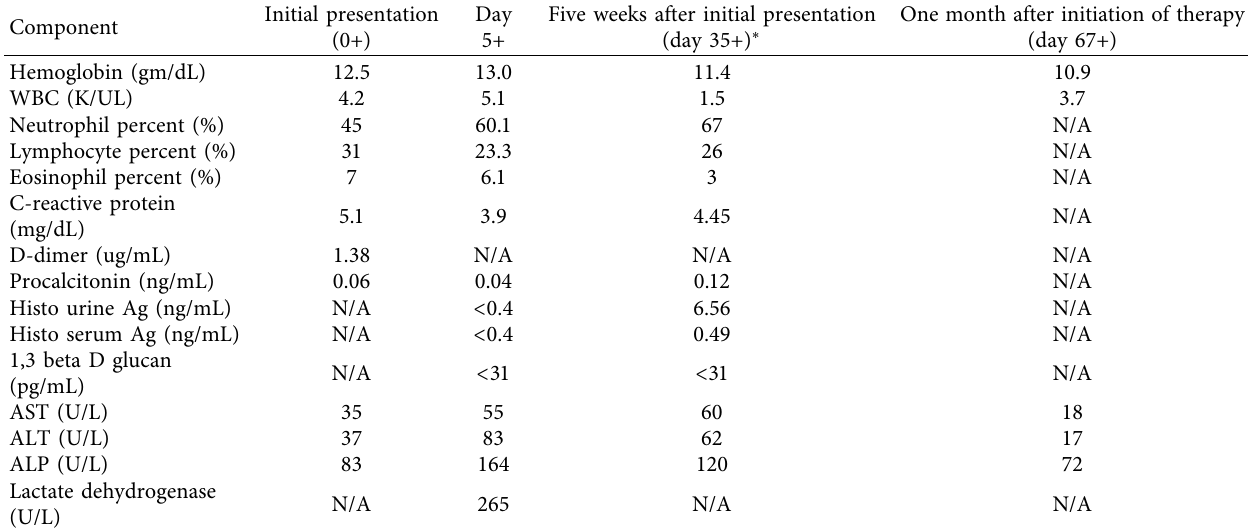
Table 1: Selected laboratory test